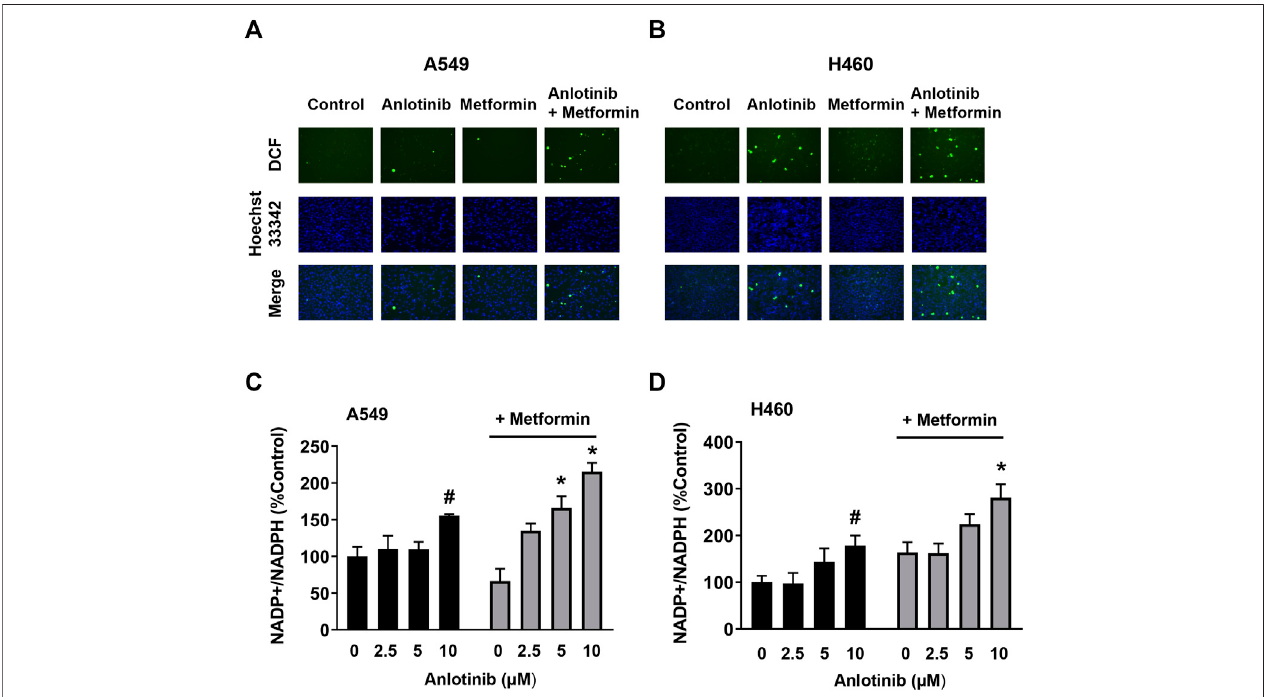
FIGURE 5 | Anlotinib combined with metformin increased intracellular ROS levels and the NADP + /NADPH ratio. A549 (A) and H460 (B) cells were incubated with anlotinib (5 μ M), metformin (5 mM), or both for 24 h. After DCF (green color) and Hoechst 33342 (bright blue color) double staining, cellular DCF fl uorescence was observedundera fl uorescencemicroscope.A549 (C) andH460 (D) cellswereexposedtotheindicatedconcentrationsofanlotiniboranlotinibandmetformin(5 mM)for 24 h. The NADP + /NADPH ratio was measured in A549 and H460 cells using an assay kit, as described in the Materials and Methods . Data are presented as